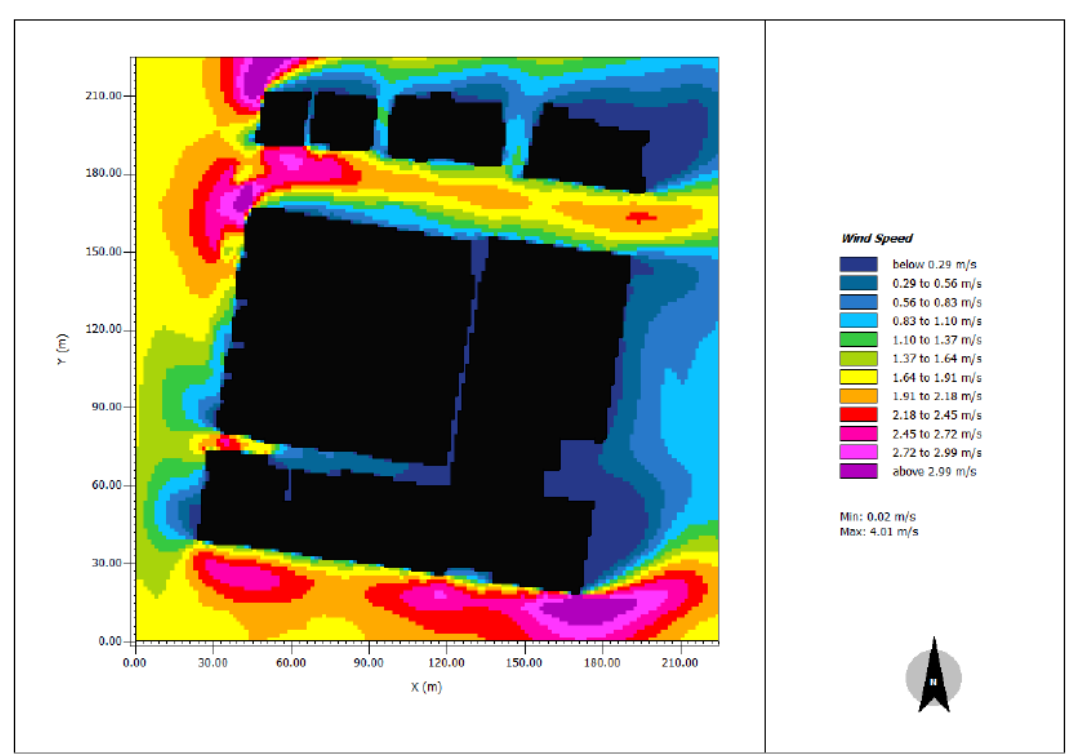
Figure 3. The wind speed distribution under unmitigated conditions for CT5 at 14:00.